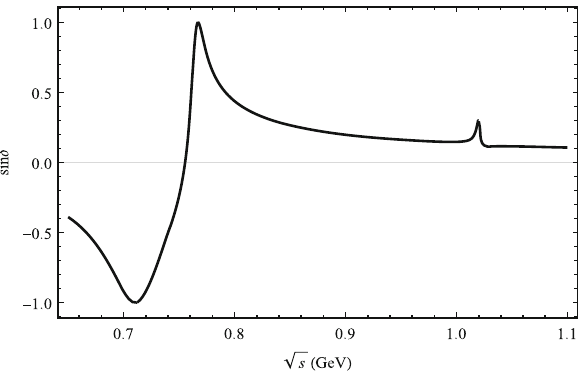
√ s corresponding to central